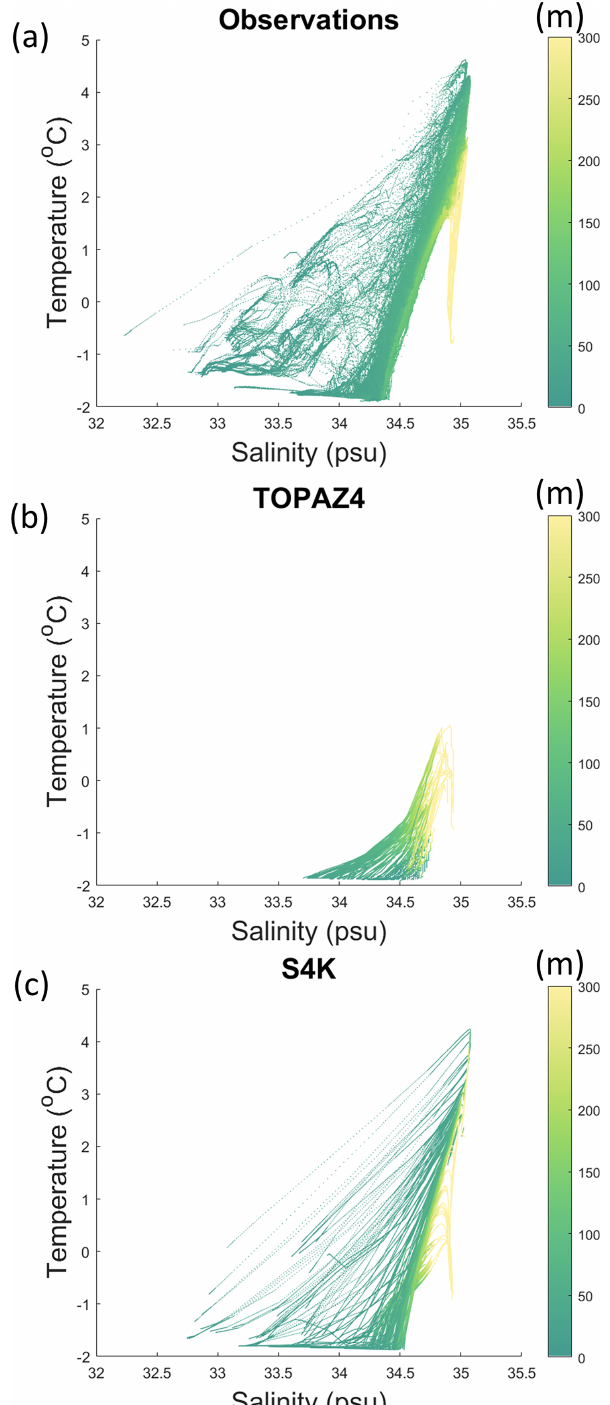
Figure 7. Temperature–salinity diagrams for observations col- lected during the N-ICE2015 expedition (Granskog et al., 2018). (a) TOPAZ4 and S4K models for the same periods and locations as the observations (b, c) , respectively. The color scale represents depth in meters (see Fig. 1, Table 5 and